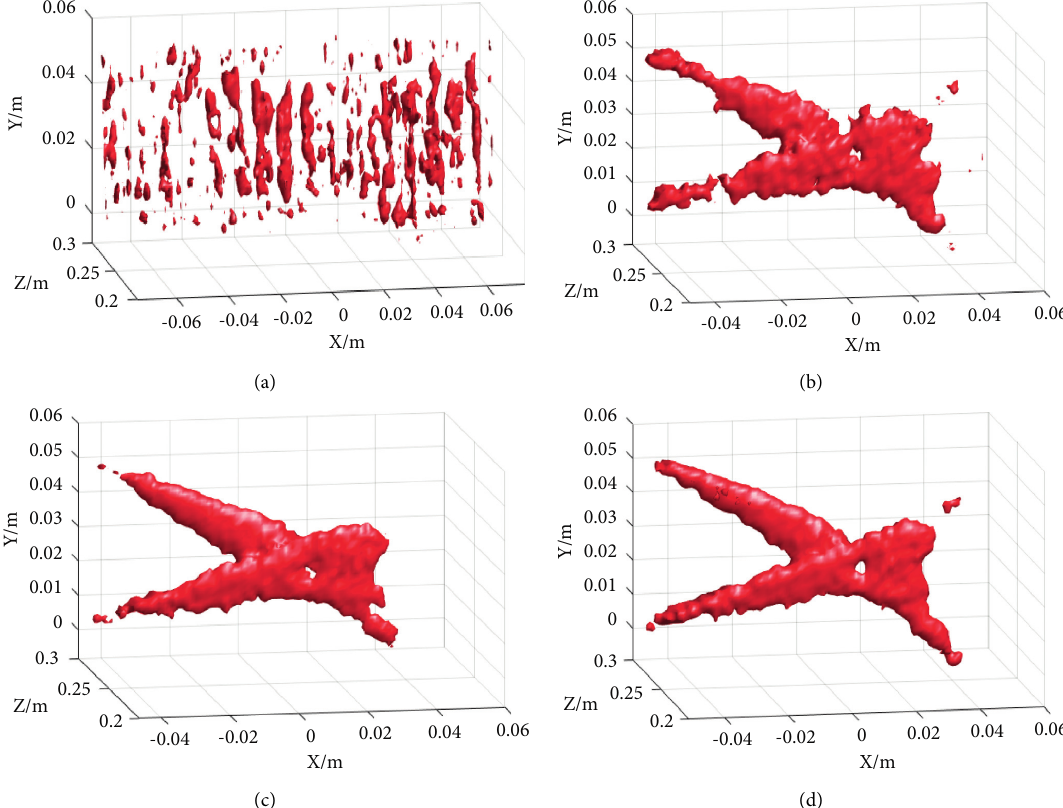
Figure 9: Reconstructed 3D images of scissors with the presented algorithm under different data sparsity rates: (a) 10%; (b) 20%; (c) 30%; (d)